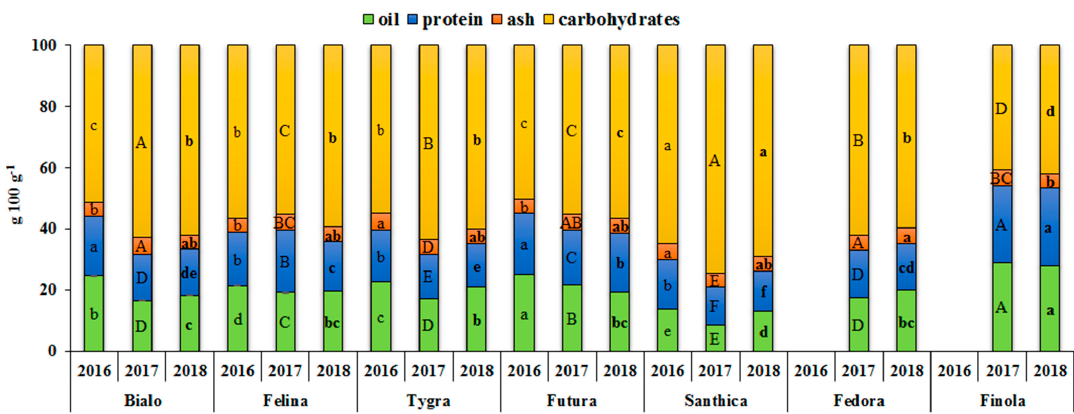
Figure 1. Nutritional profile showing the oil, protein, ash, and carbohydrate contents (g 100 g –1 seed) of hemp seeds from the seven industrial hemp cultivars cultivated in this study and for three growing seasons (2016, 2017, and 2018). For each year, means within columns in the same color followed by the same letter (lower case, capitals, and lower case in bold for 2016, 2017, and 2018, respectively) are not significantly different ( p > 0.05).